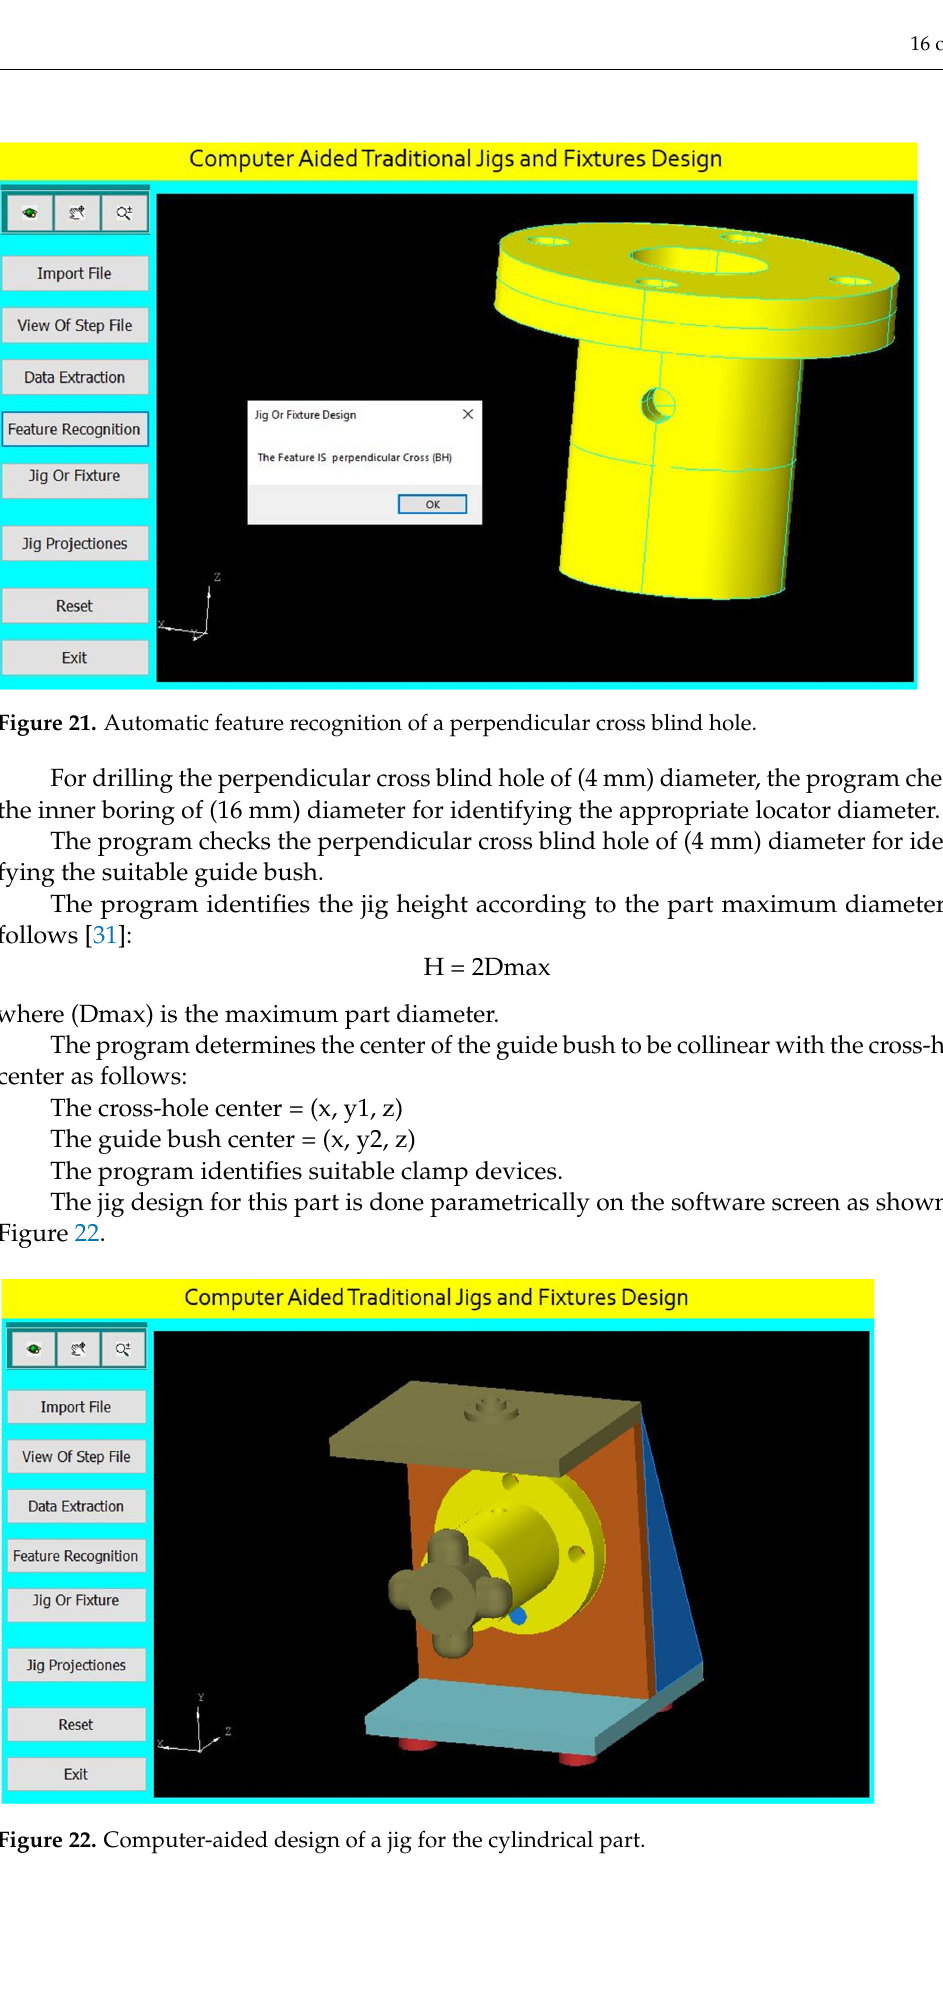
Figure 20. The faces of the part.